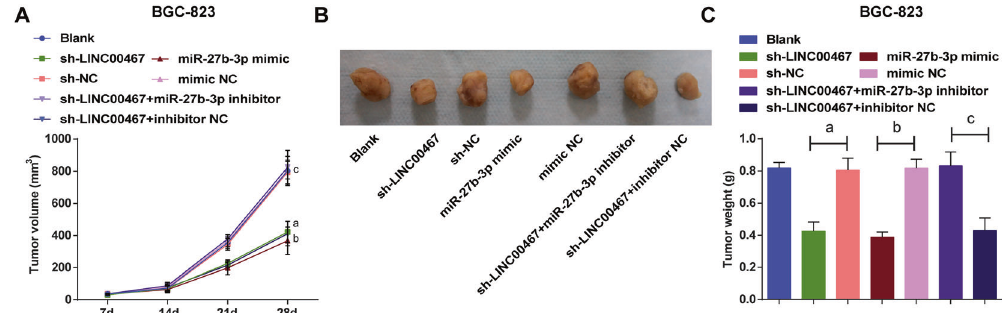
Fig. 5 Knockdown of LINC00467 or elevation of miR-27b-3p decelerates GC tumor growth in vivo. A Growth curve of BGC-823 xenografts. B Representative images of BGC-823 xenografts. C Weight of BGC-823 xenografts in each group; a P < 0.05 vs the sh-NC group, b P < 0.05 vs the mimic NC group, c P < 0.05 vs the sh-LINC00467 + inhibitor NC group; n = 6; the measurement data were expressed as mean ± standard